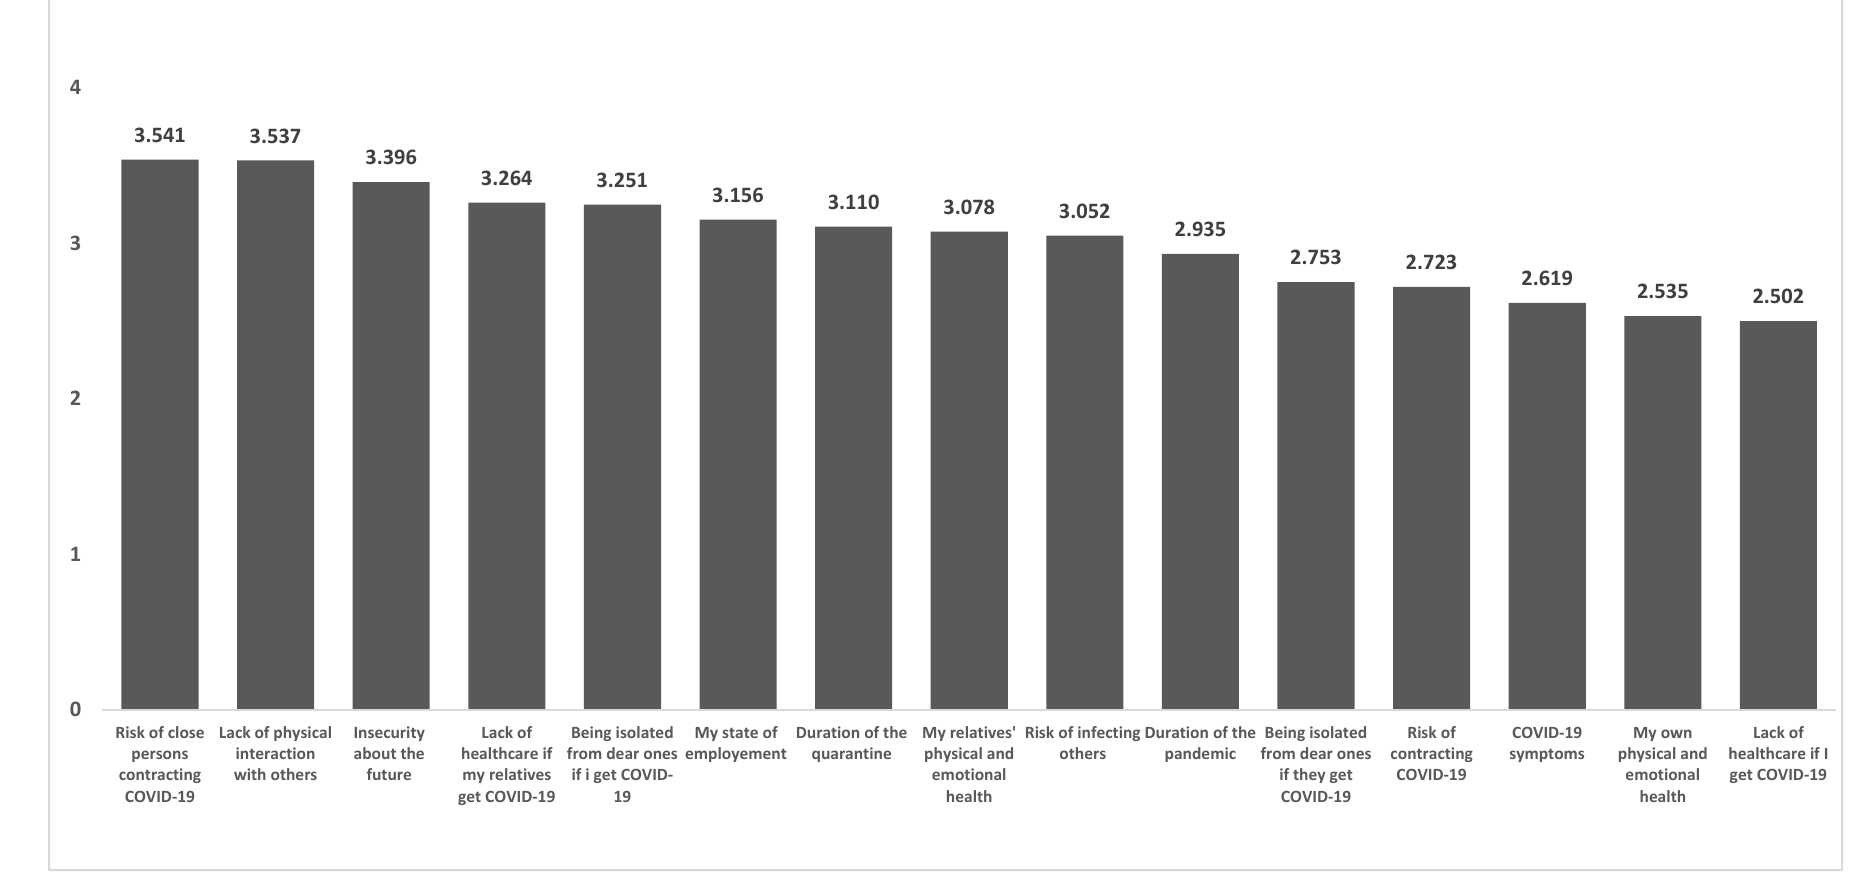
Figure 2. Graphic representation of raw mean scores on fears related with the COVID-19 pandemic reported on a 1 (not at all) to 5 (extremely) response scale by the entire sample (n = 231).